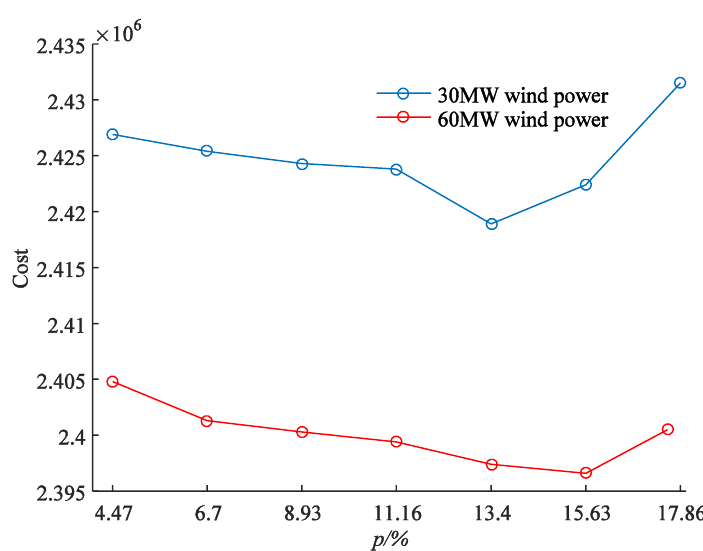
Figure 22. Curve of best fuel cost varies with penetration at two times the wind power.